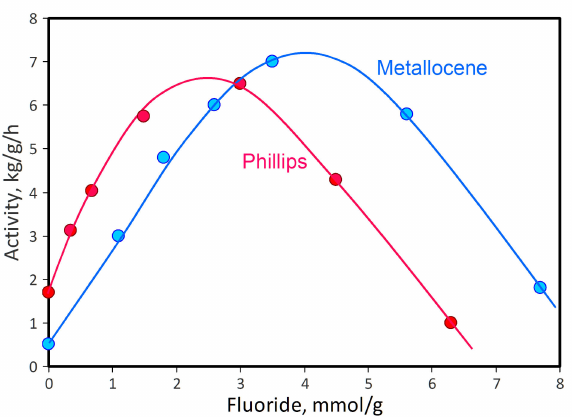
Figure 10. Activity from a metallocene and Phillips catalyst both supported on fluorided silica- alumina, as a function of the fluoride